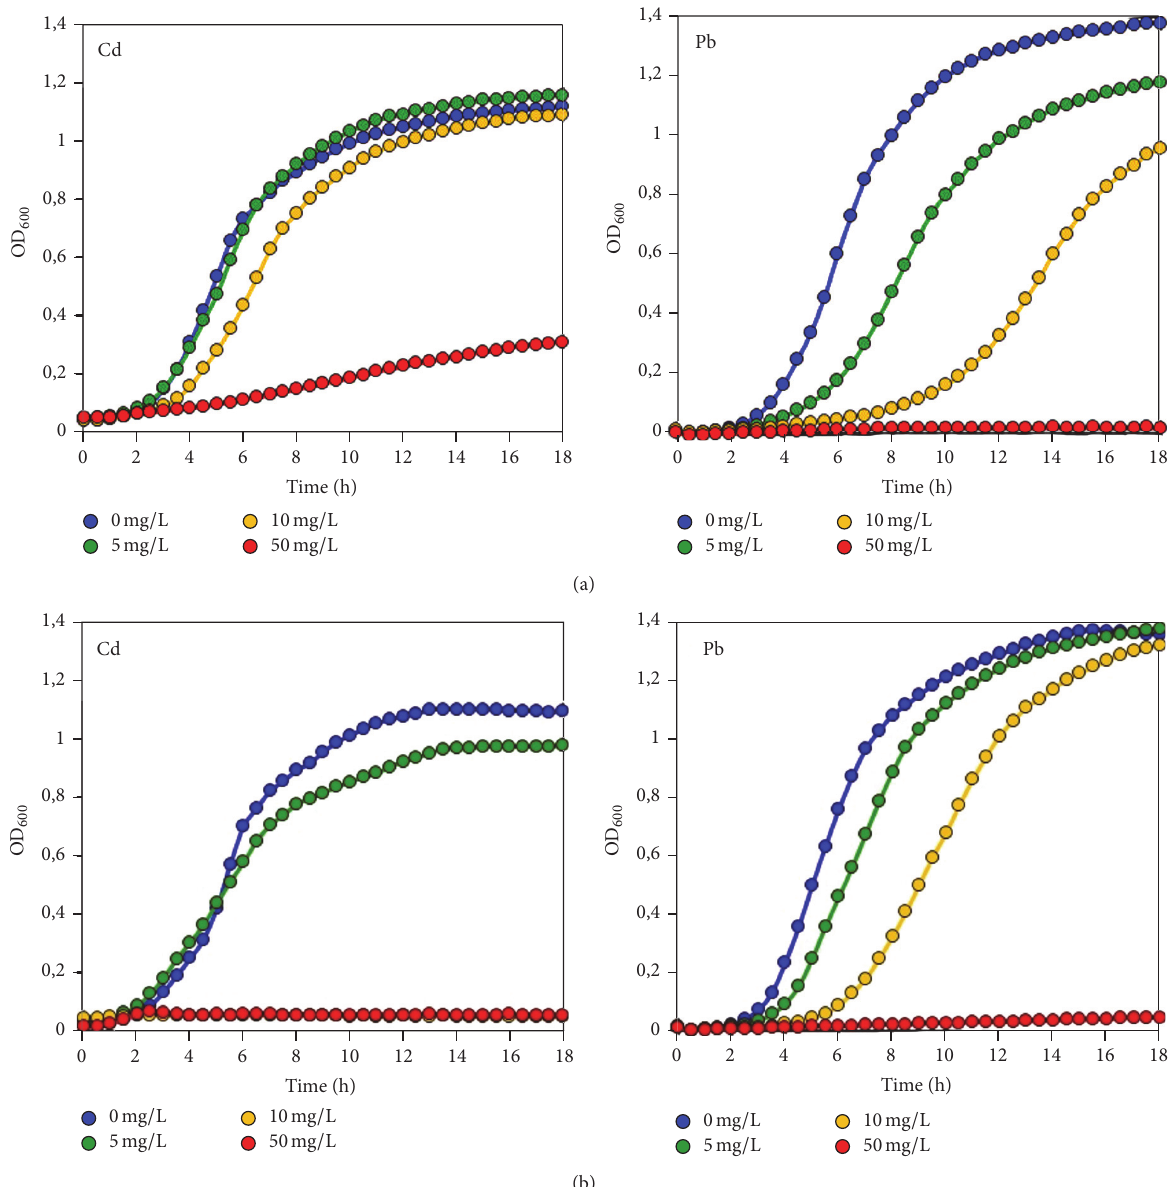
Figure 1:Growth of Lactobacillus plantarum S1 (a)and L. buchneri 20057 (b)inthepresence ofCd orPb(seegrowth curves of all Lactobacillus strains in Supplemental Figures